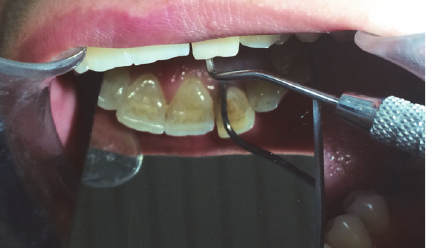
Figure 1: Preoperative photograph; a 7mm localized pocket was detected on the palatal of tooth